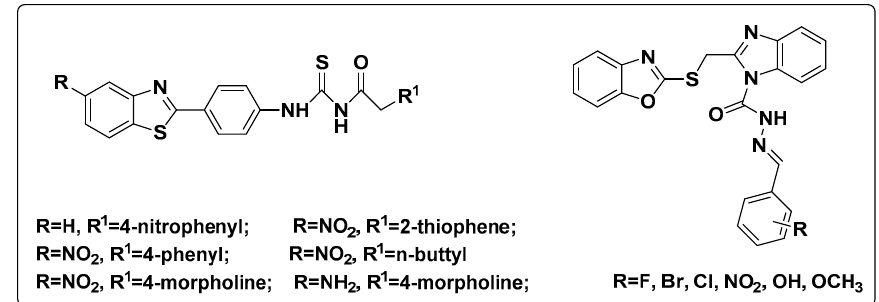
Figure 2. Chemical structures of the antifungal compounds bearing benzoxazole and benzothiazole scaffolds.